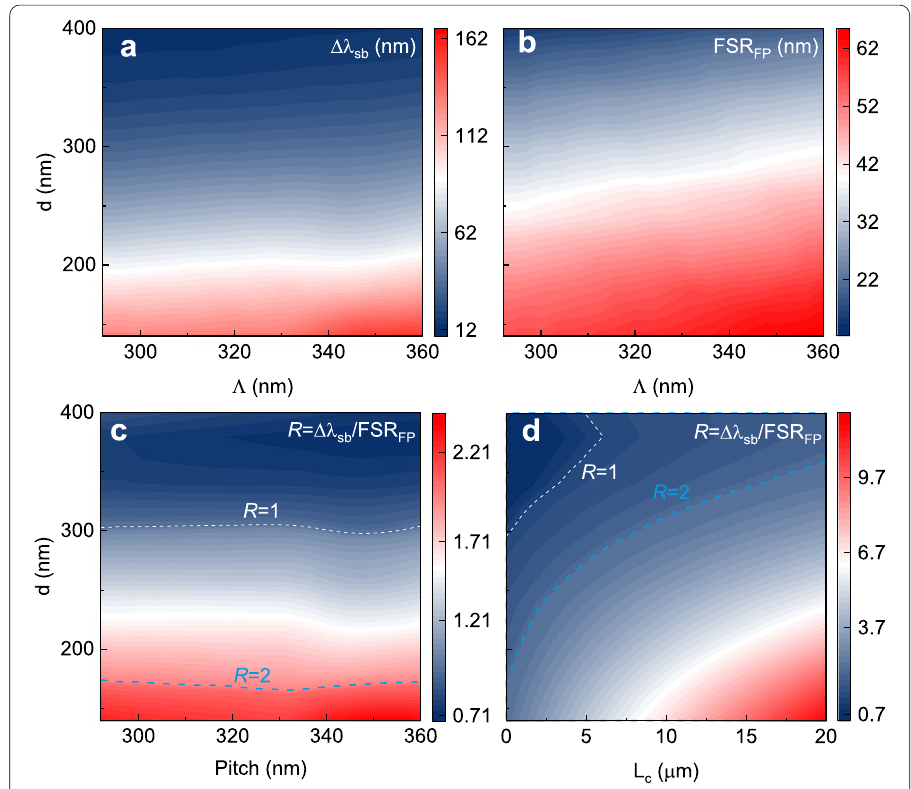
Fig. 3 FSR-free condition analysis. Contour maps of a the stopband of Bragg grating Δλ sb , b the FSR FP of F-P cavity, and c the ratio R ( R Δλ sb / FSR FP ) as functions of Λ and d . Waveguide width d and L c are 0.5 μm and = 0 μm. d Simulations of the ratio R as a function of L c and d . Waveguide width d and Λ are 0.5 μm and 316 nm. The dashed white and blue contour lines in c and d represent the value of R pitch number of the Bragg grating and the tapered grating are 150 and